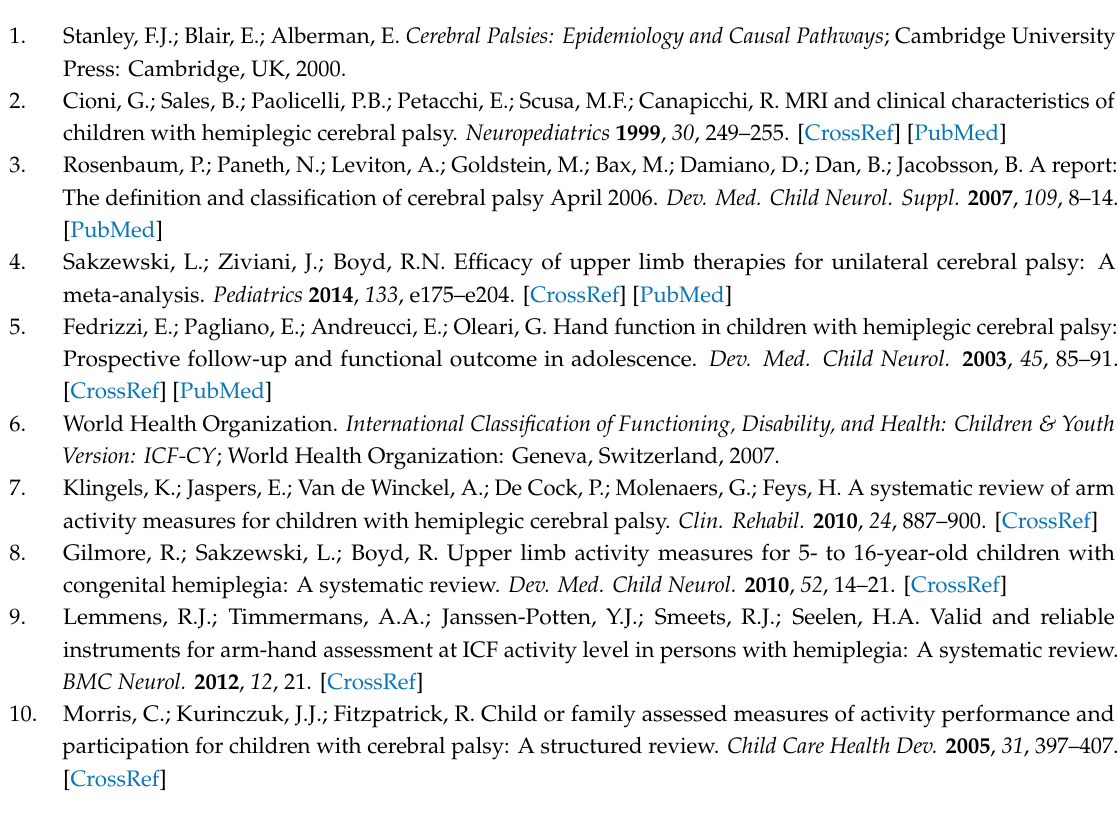
Table S1: Correlations between CSP-2 and PEDI-CAT domains, Table S2: Correlations between CSP-2 and KD-27 and KD-10